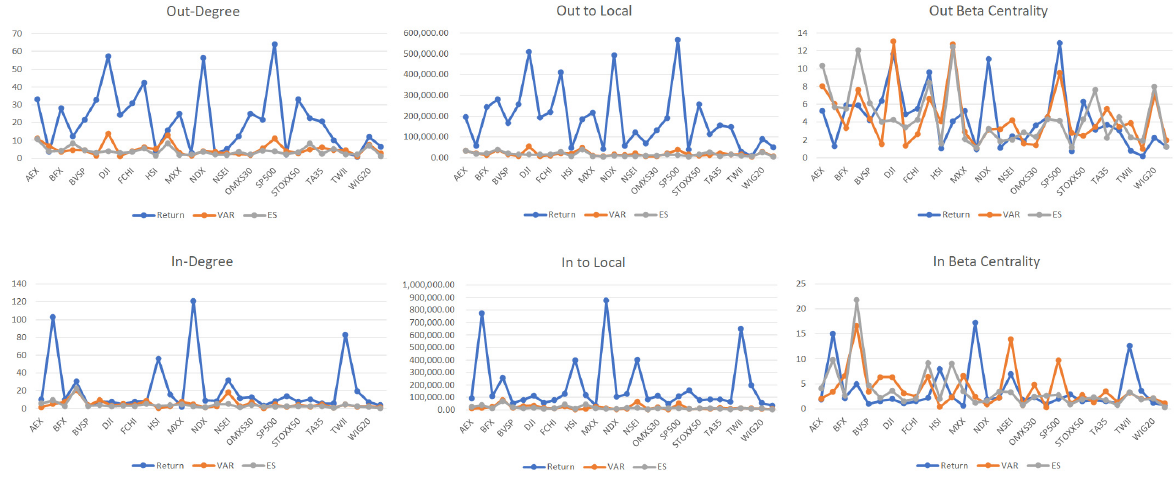
Figure 5. Centrality Measures for Networks 𝑁 (cid:3045) , 𝑁 (cid:3049)(cid:3028)(cid:3045) and 𝑁 (cid:3032)(cid:3046)